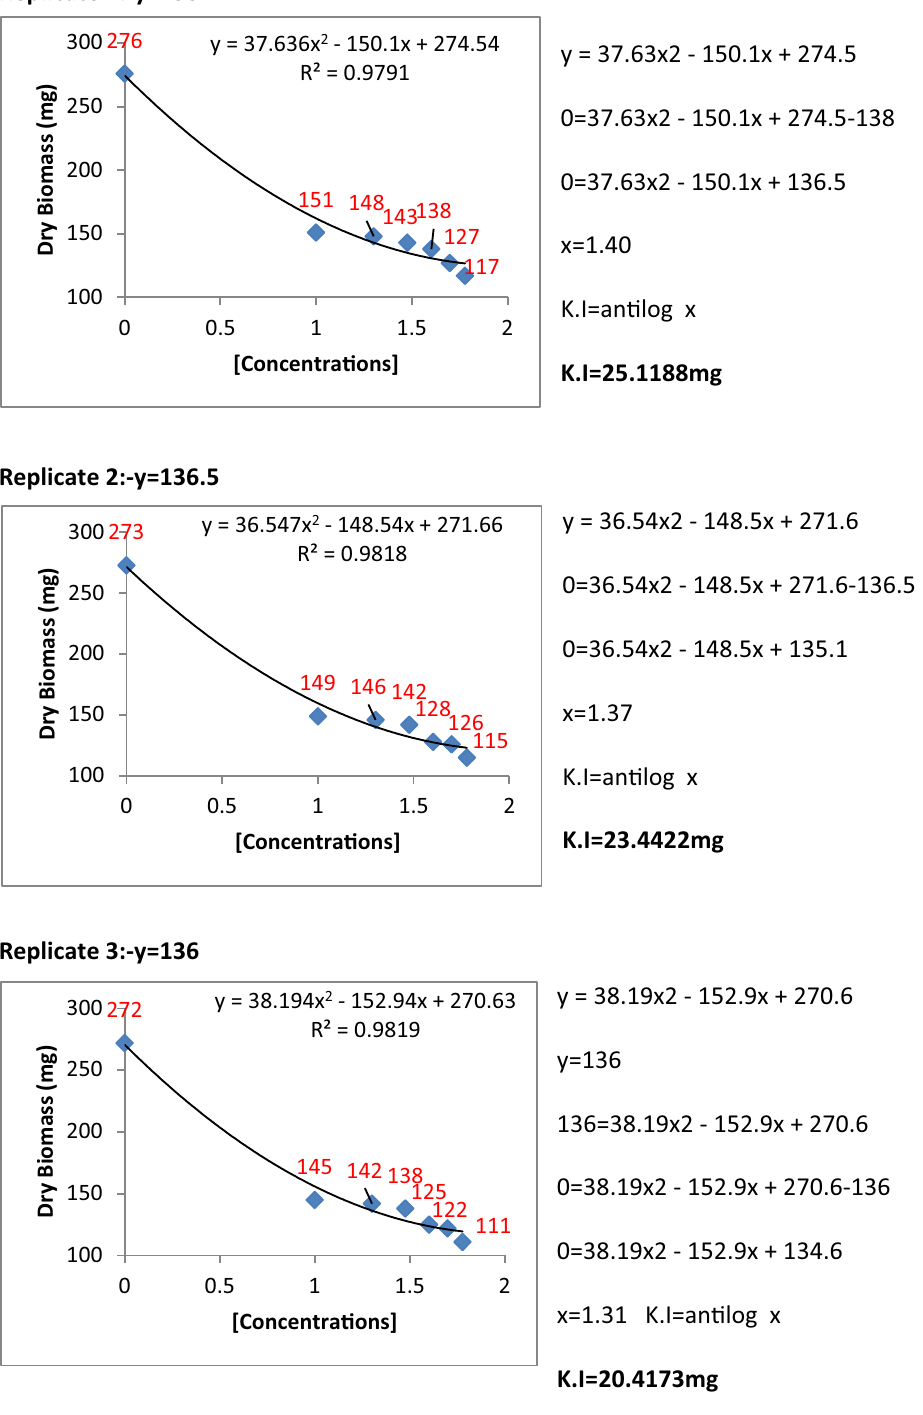
Figure 13. Kinetic constants of inhibition of P. herbarum by metabolites of P. verrucosum (3